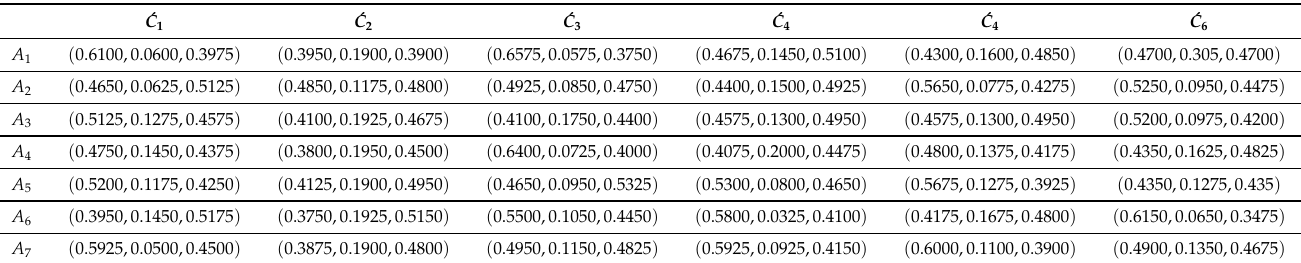
Table 16. Aggregated decision matrix.